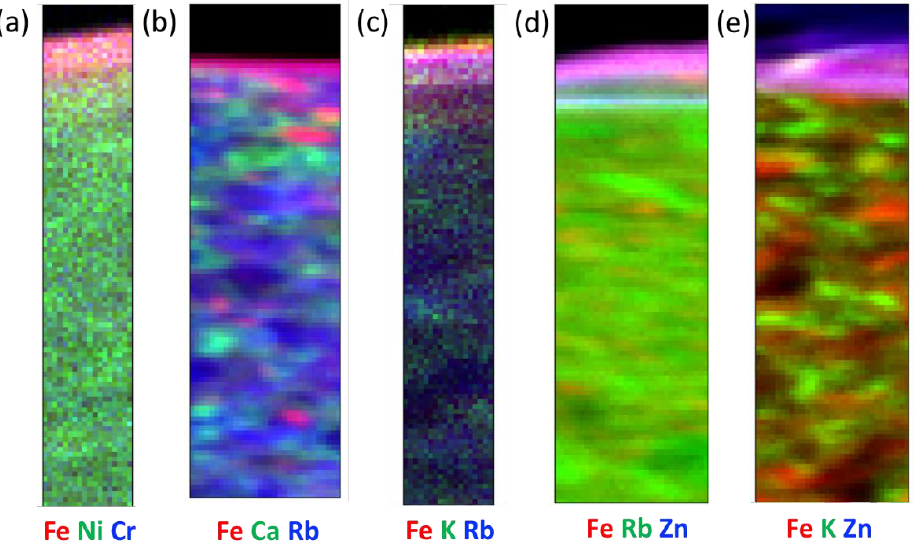
Figure 1. RGB correlation considering relevant elemental markers in cross-section geometry for ( a ) Attic (GEVN9, 100 × 500 µm), ( b ) Laconian (GEL5, 150 × 500 µm), ( c ) Sicilian (GEVN15, 100 × 500 µm), ( d ) Chalcidian (ME68, 150 × 500 µm) and ( e ) Locrian (?) (GEVN10, 150 × 500 µm) products.